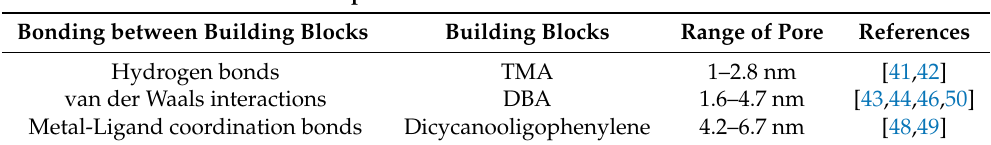
Table 1. Table summarizing the three groups of building blocks used to form nanoporous self-assembled